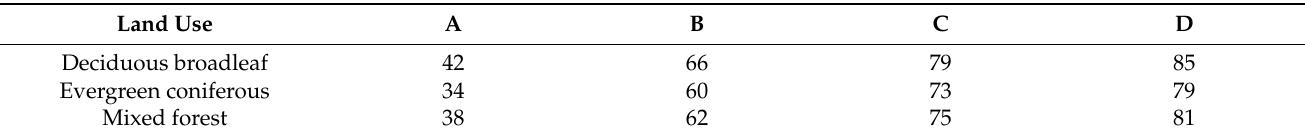
Table 3. CN values (-) applied over Tinella watershed as a function of forest type (deciduous broadleaf, evergreen coniferous and mixed forests) and hydrological group (A, B, C and D).